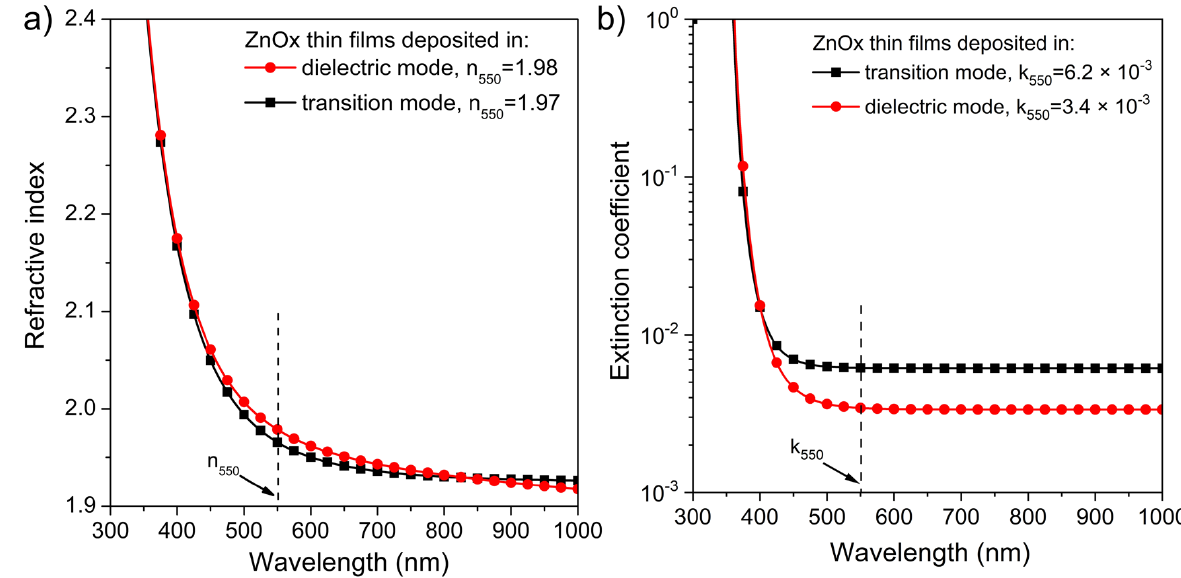
Figure 9. Spectral characteristics of: ( a ) refractive index and ( b ) extinction coefficient of transparent ZnOx thin films.